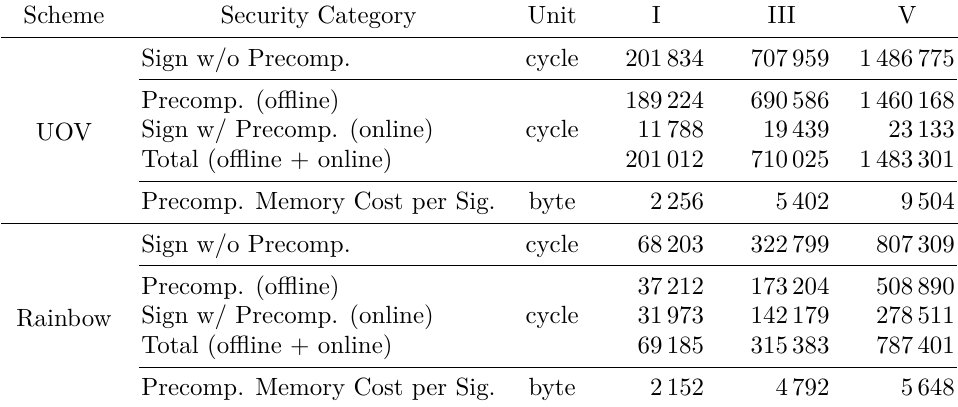
Table 6: UOV/Rainbow implementations with and without precomputation at three security categories, in CPU cycles and